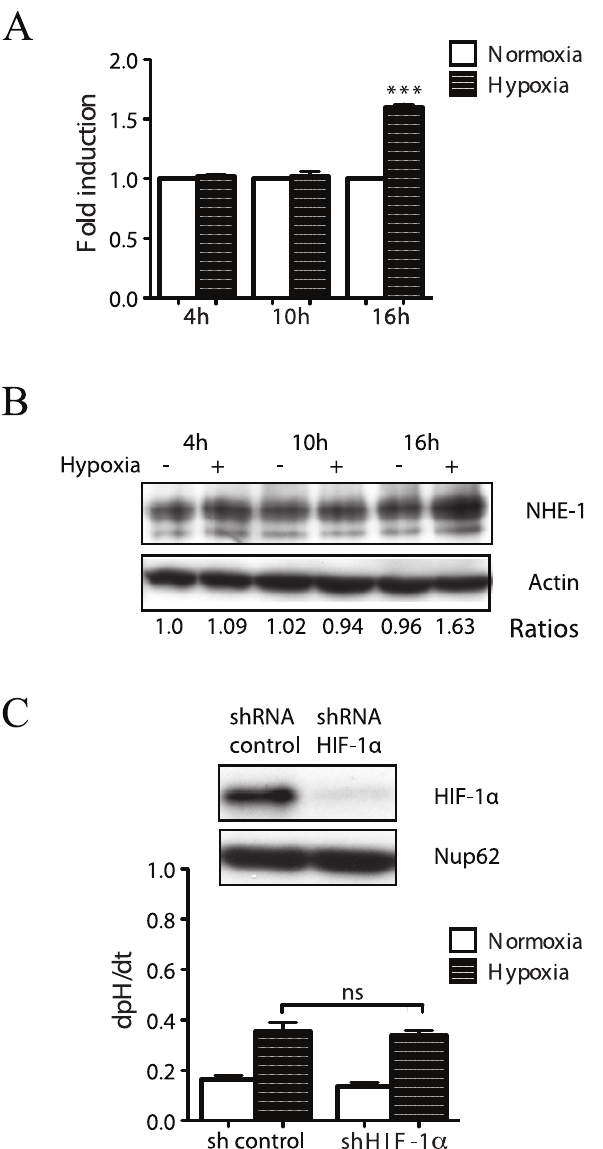
Figure 2. Hypoxia-induced NHE-1 activity occurs in a HIF-1- independent manner. HT-1080 cells were exposed to normoxic or hypoxic conditions for the indicated times. (A) NHE-1 mRNA expression measured by RT-PCR (n=3). (B) Representative immunoblot showing NHE-1 expression in cell lysates (n=3). Actin was used as a loading control. (C) Na + /H + exchange rate in HT-1080 cells transfected with HIF- 1 a shRNA or control (scrambled) shRNA and exposed to 21% O 2 or 1% O 2 for 4 h. Immunoblot showing HIF-1 a knock down in cell lysates. Nup62 was used as a loading control. NS: not significant. Columns represent the mean 6 SEM indicated by the horizontal bars. The asterisks correspond to, *** p , 0.0001.